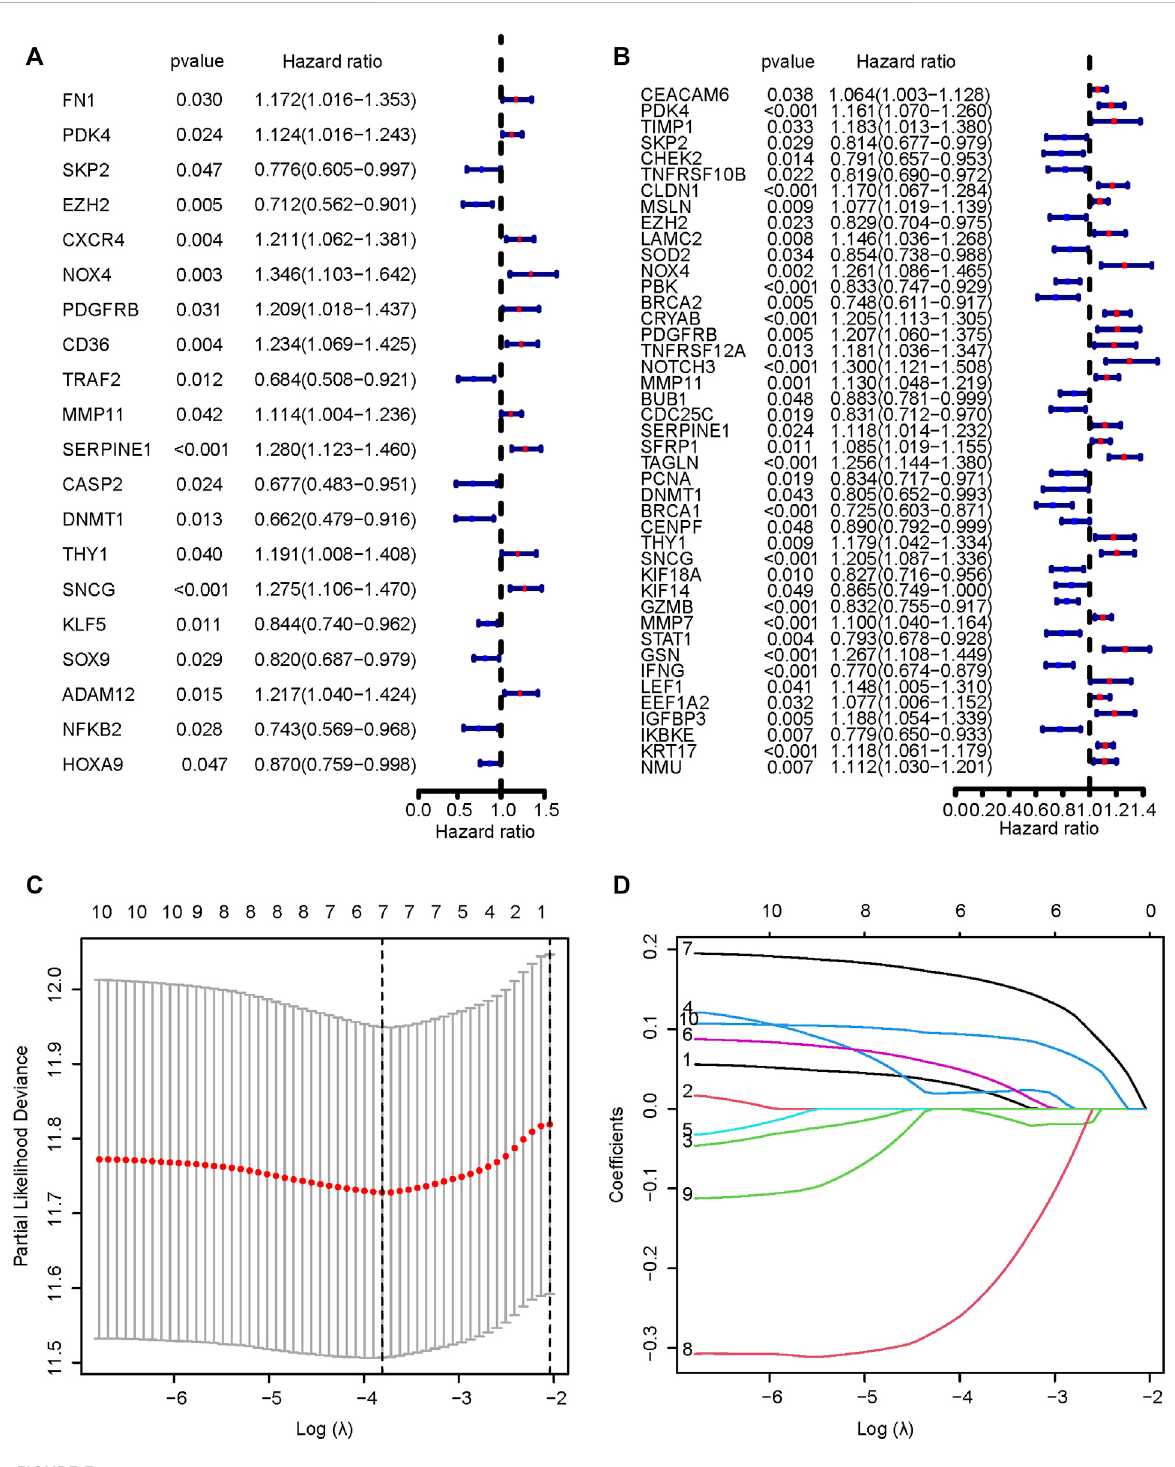
FIGURE 3 Univariable Cox regression analysis. The results of univariable Cox regression analyses of TCGA (A) and GEO (B) cohorts. (C,D) The results of LASSO analysis of ten prognostic ARGs. TCGA, The Cancer Genome Atlas; GEO, Gene Expression Omnibus; LASSO, Least Absolute Shrinkage and Selection Operator; ARGs, anoikis-related